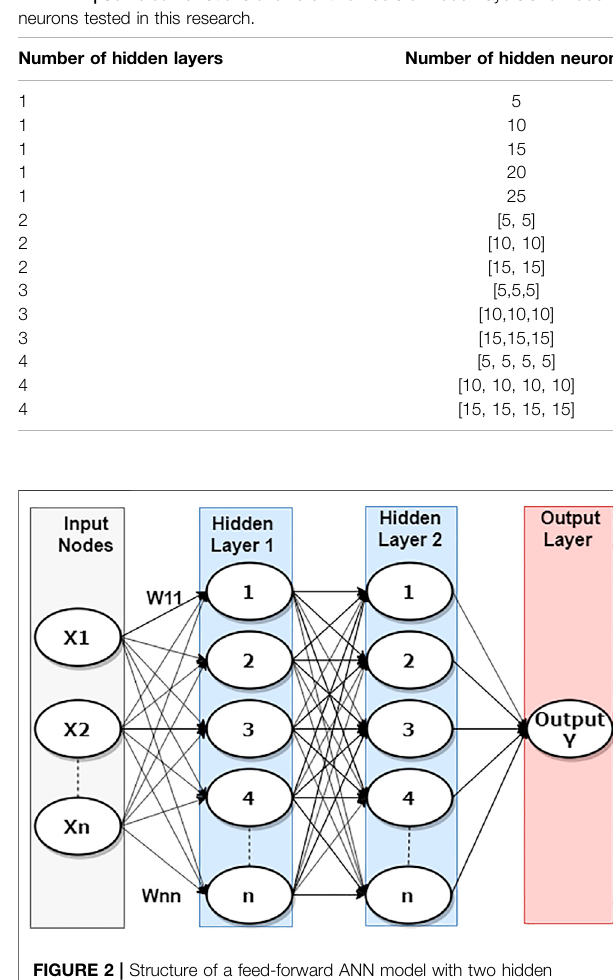
FIGURE 2 | Structure of a feed-forward ANN model with two hidden layers each contains ten hidden